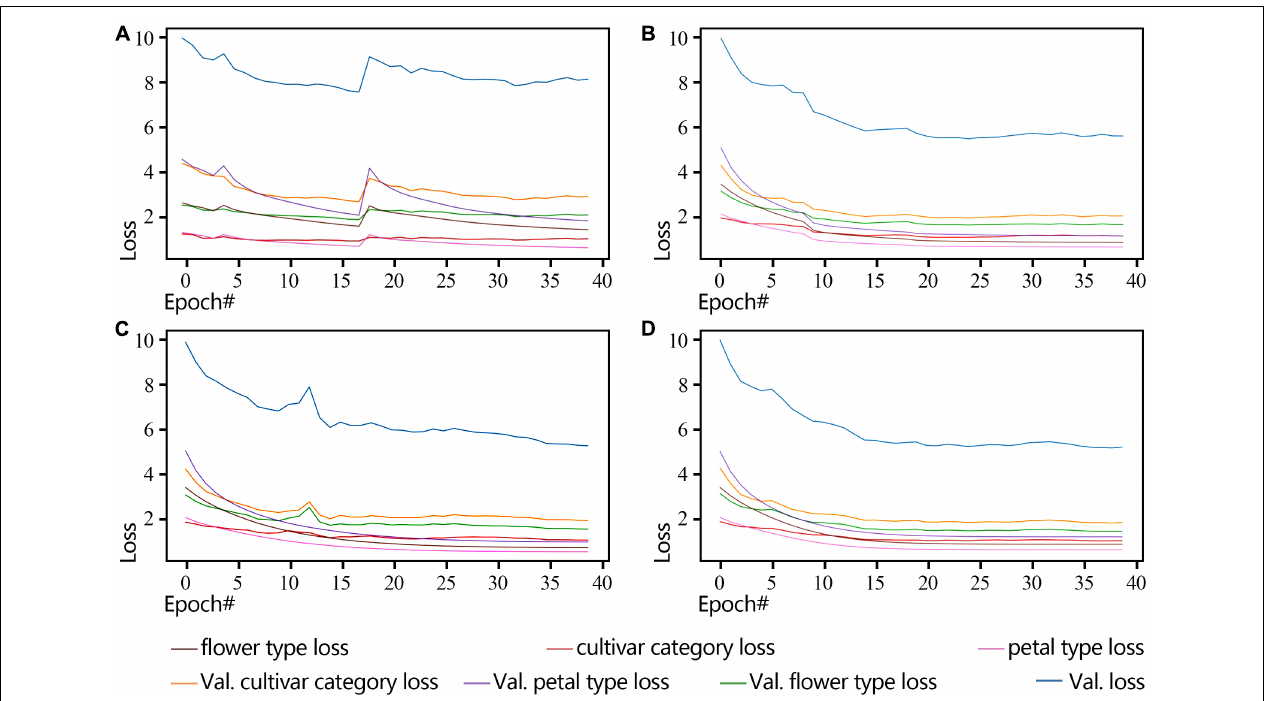
FIGURE 7 | ResNet18 Loss curve of a non-pre-training model during training and validation (2018 dataset). (A) Standard-decay. (B) Step-decay. (C) Line-decay. (D) Poly-decay.